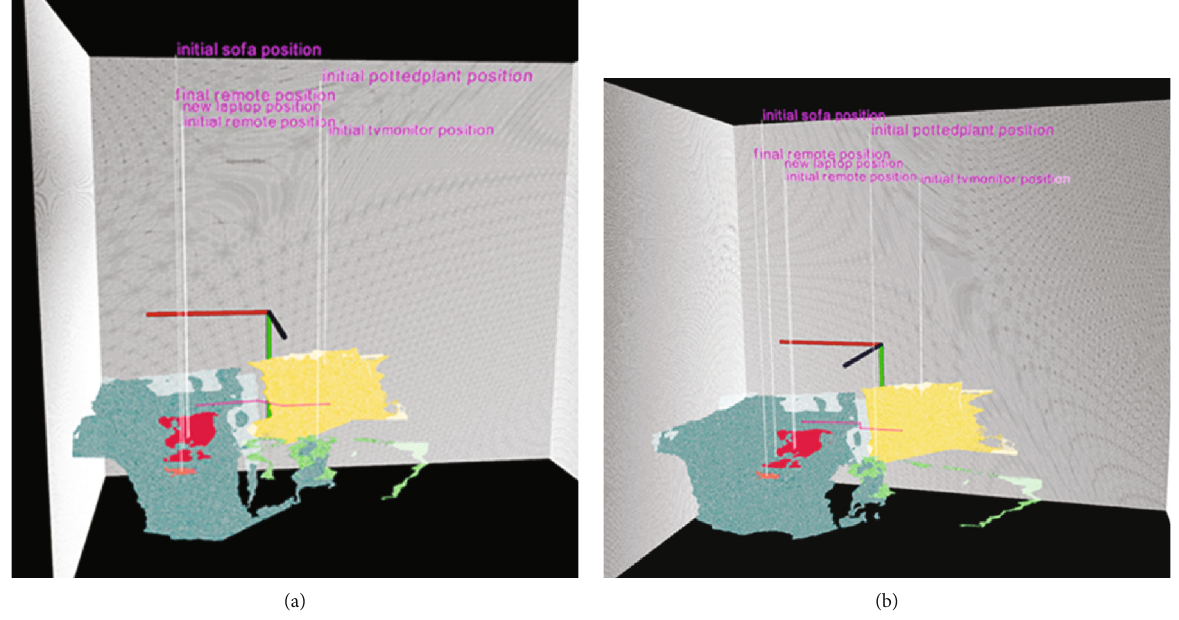
Figure 8: Two views of the calibrated virtual scene based on the merged point clouds of the two depth sensors. Both views show the segmented portion of the point clouds associated with the detected objects after the older adult has left the monitoring area. Virtual reconstruction size of the point cloud is based on the physical sizes of the objects. The detected objects in the RGB image are used to segment the associated point cloud for determining their approximate position with respect to the real and virtual scene. For example, the orange path represents point clouds associated with the fi nal position of the remote. Although it is not used as a part of the results of this paper, pink path shows an example trajectory of person while active in the